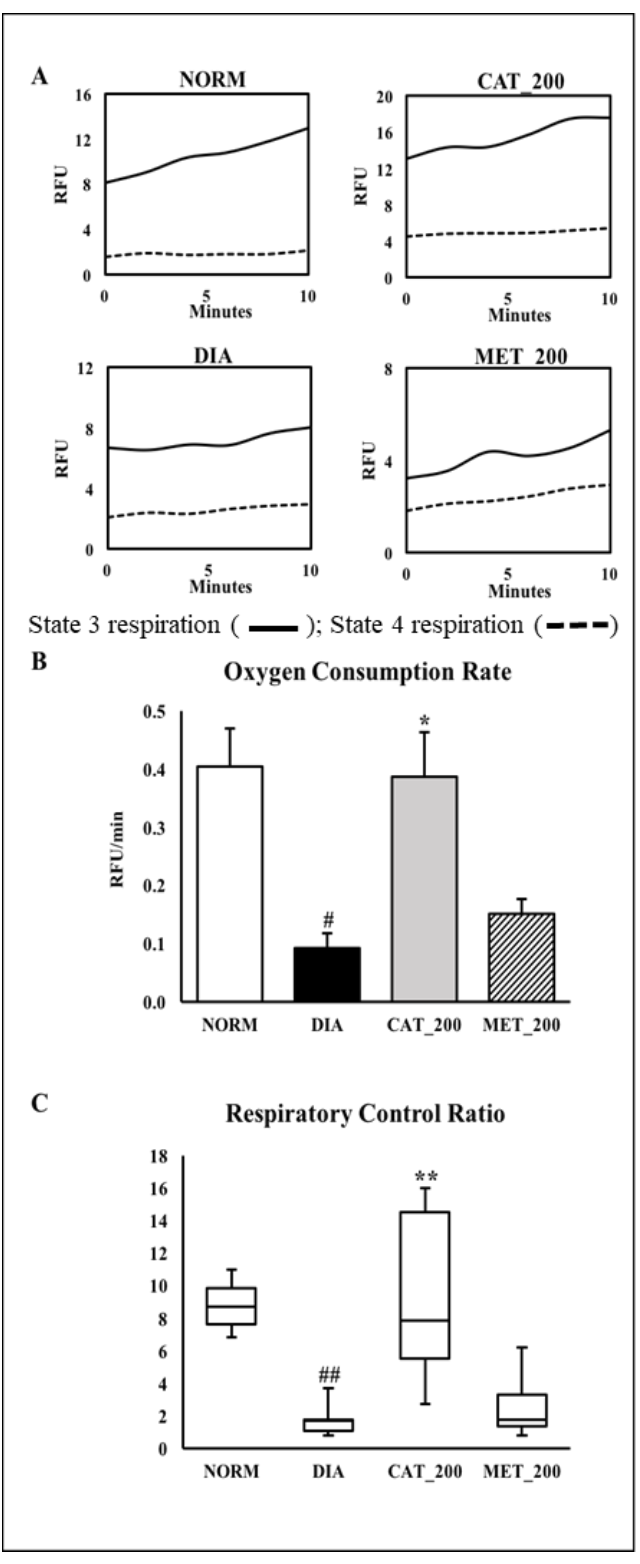
Figure 5. Effect of catalpol on state-3/stae-4 respiration, oxygen consumption rate (OCR) and respiratory exchange rate (RCR) ( A ) Representative trace of oxygen consumption shown by relative fluorescent units (RFU) over time between 0 and 10 min. ( B ) Oxygen onsumptionrate of isolated